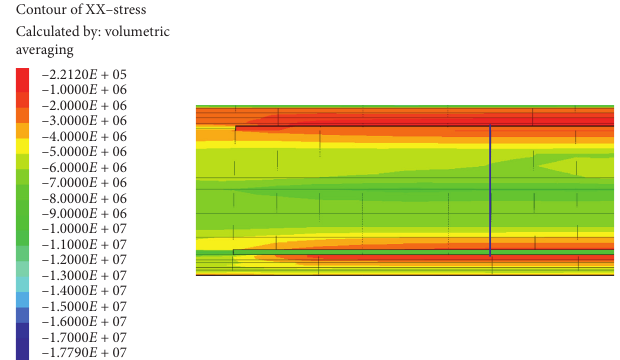
Figure 9: The horizontal stress cloud diagram of the third left working face.